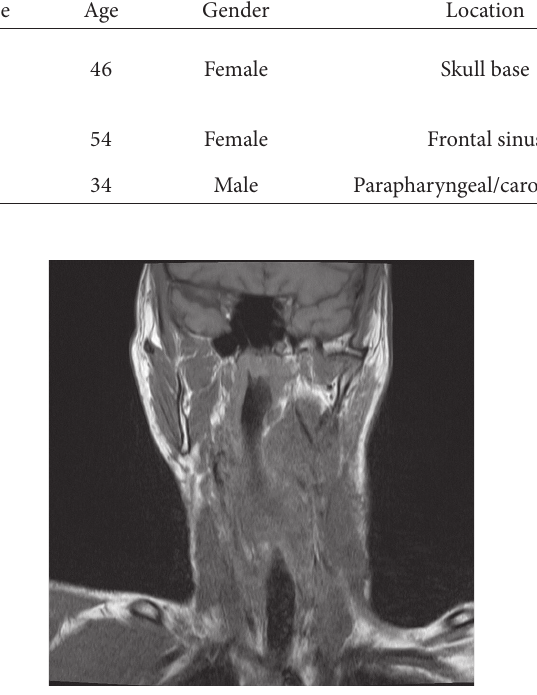
Figure 6: Coronal T1-weighted MRI showing the left pharyngeal mass with airway